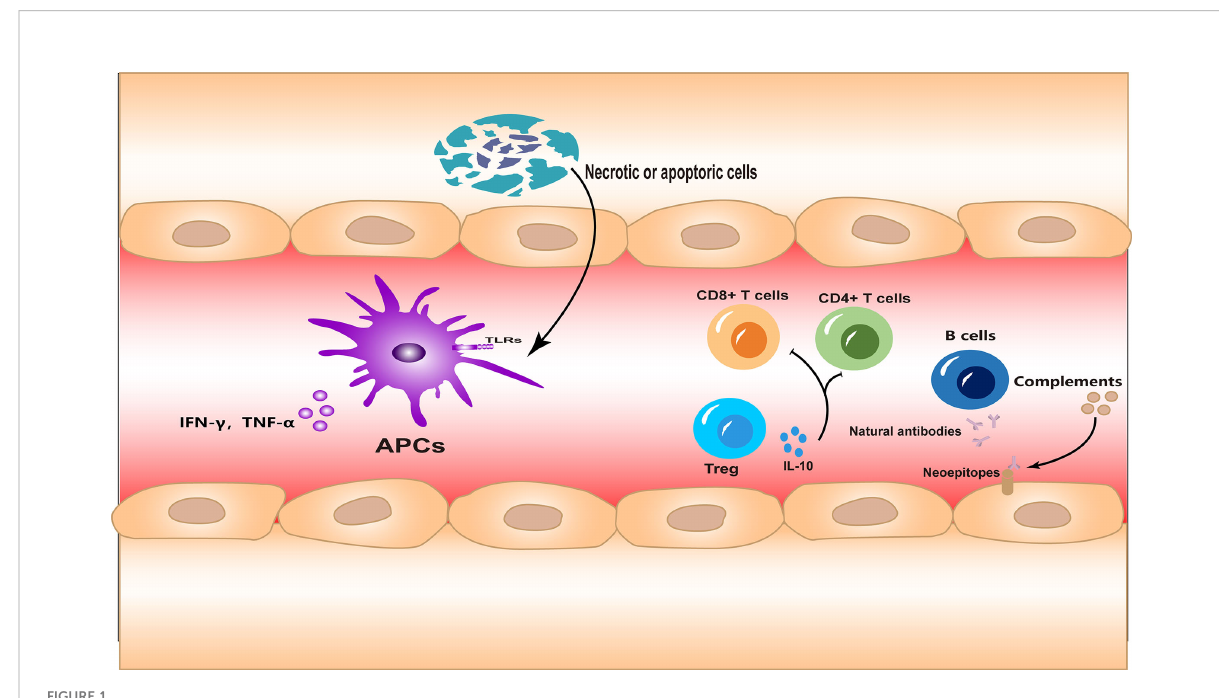
FIGURE 1 The innate and adaptive immune responses and autoimmunity are all involved in ischemia – reperfusion (I/R) injury. Necrotic or apoptotic cells can directly activate the innate immune response during I/R injury. Different subsets of lymphocytes are involved in the adaptive immune response in different forms. Meanwhile, neoepitopes are exposed to injured tissues, inducing autoantibody production and complement system